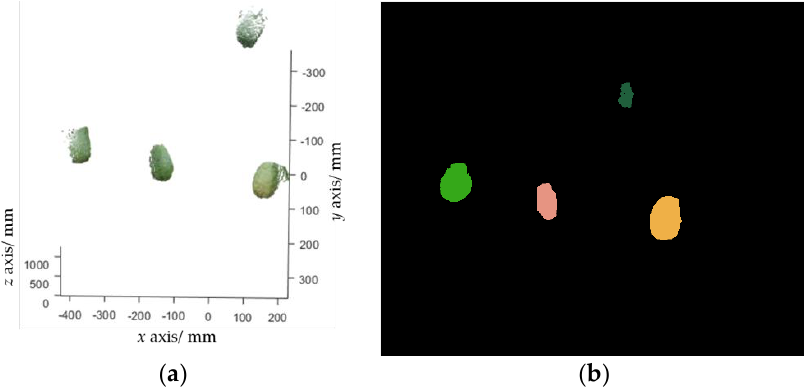
Figure 5. Fruit detection results. ( a ) Fruit point cloud extracted from Figure 4b; ( b ) clustering results, where each cluster is marked with a random color.